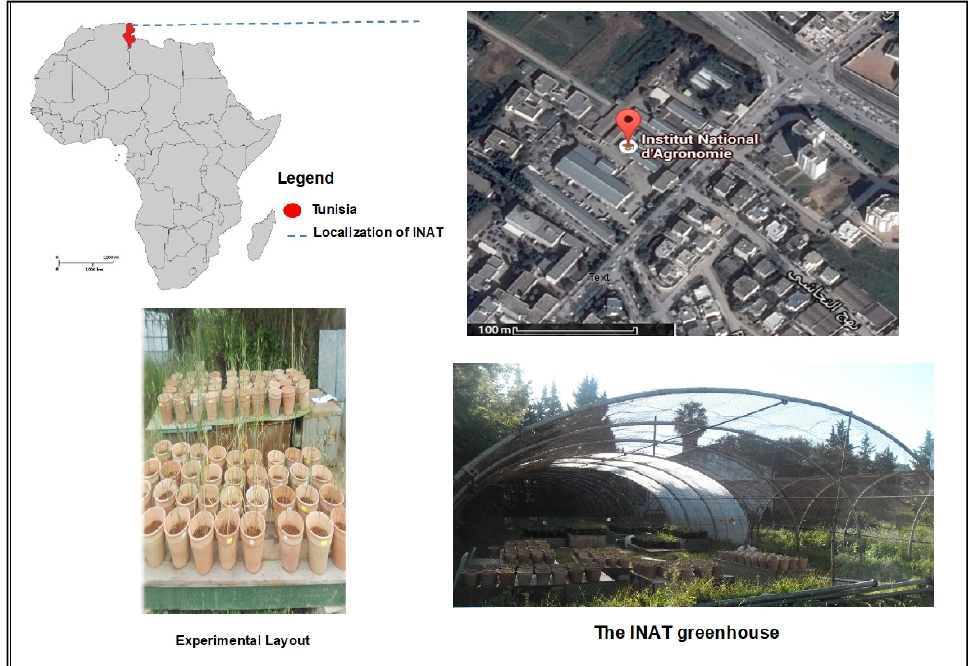
Figure 1. Location of experimental